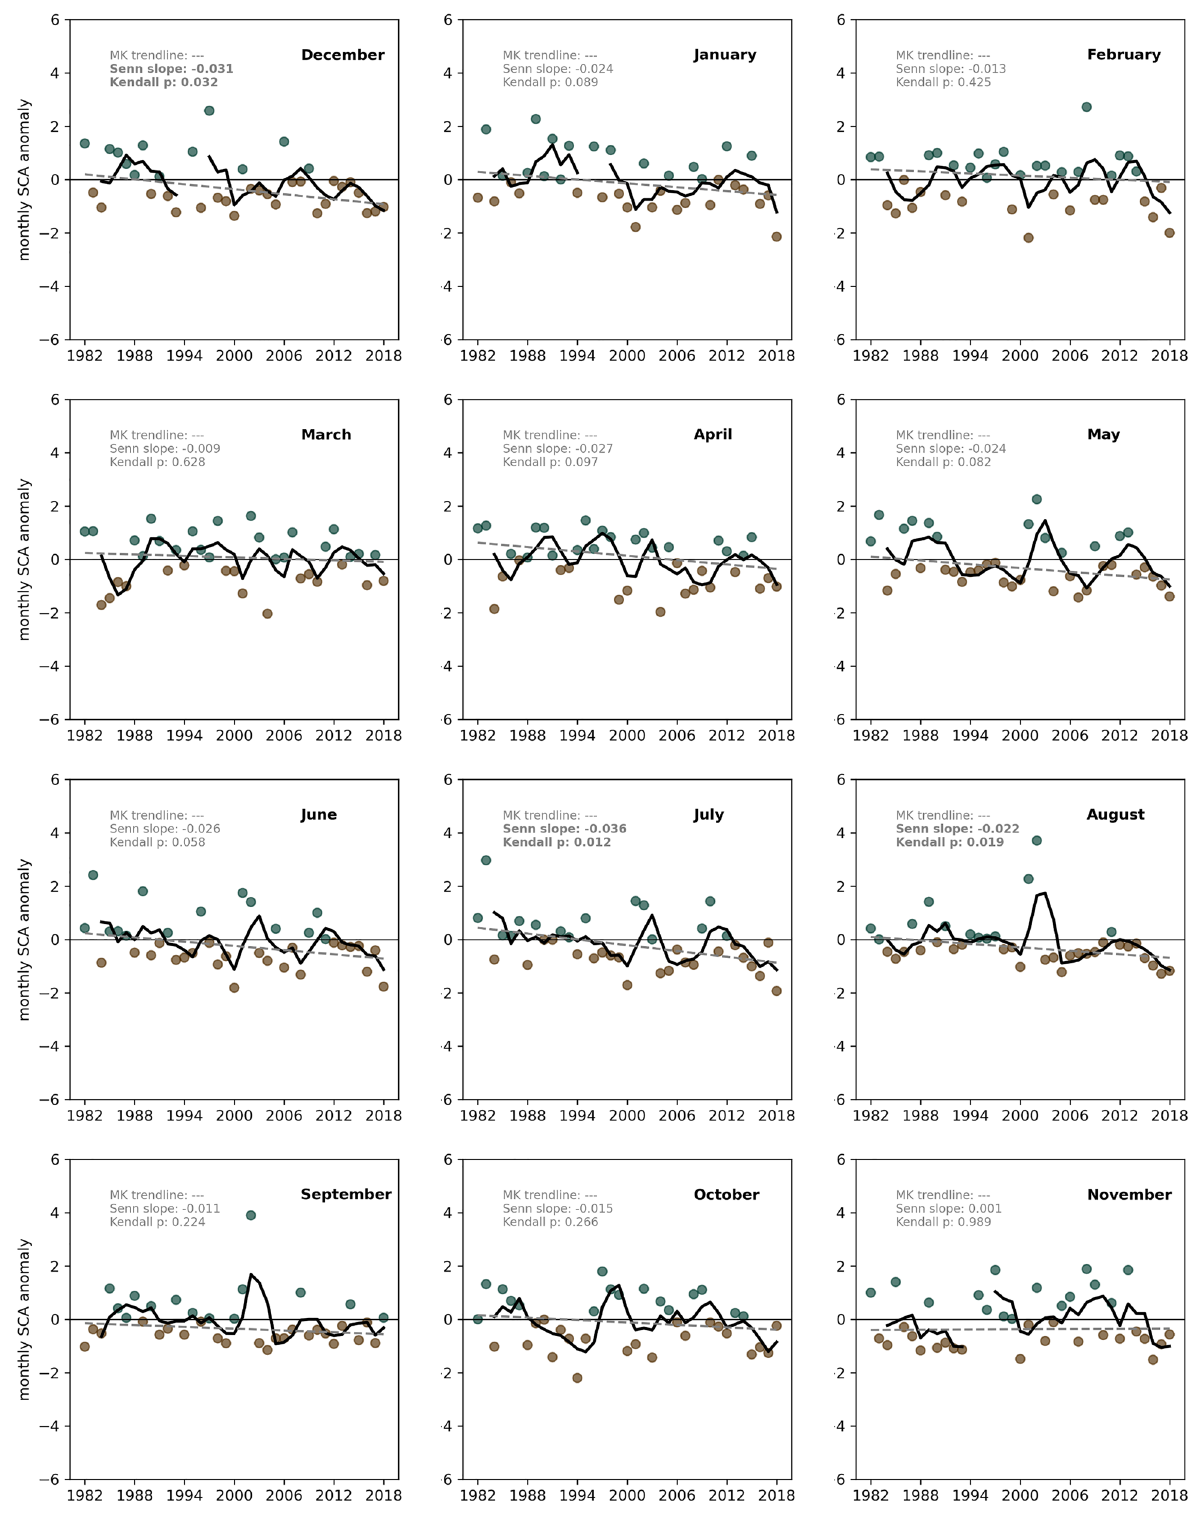
Figure 3. Seasonal changes in snow cover extent. Monthly SCA anomalies for the entire HKH region with respect to the 1982–2010 reference period. Teal and brown dots denote positive and negative yearly anomalies, respectively. Solid black lines denote 3-year running mean, dashed lines denote the MK trendline and statistics (Senn slope and Kendall p) are given at the top of each box (bold indicates significant values). Missing data from November 1994 to February 1995 are visible. All numeric details can be found in the Supplementary Table